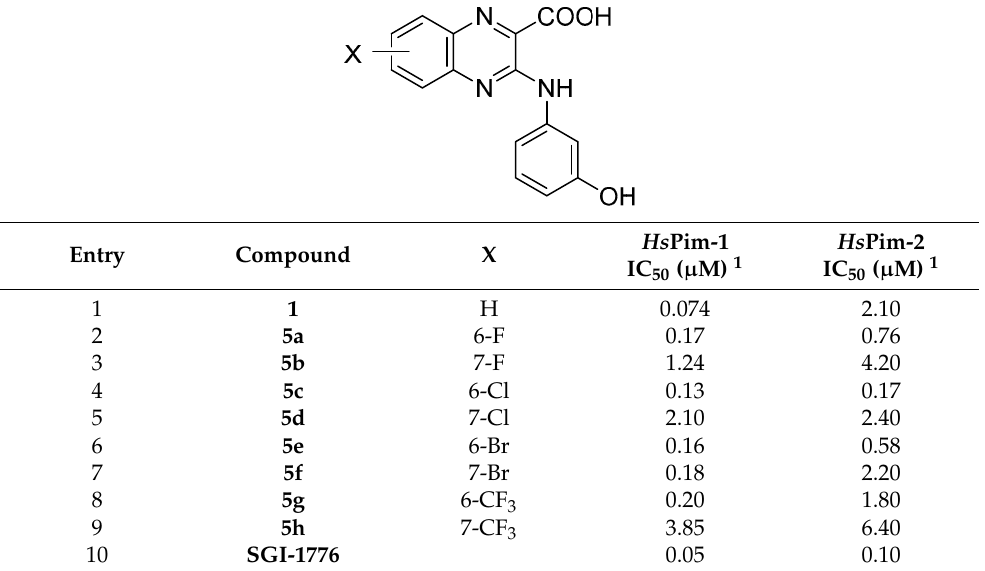
Table 1. Enzymatic assays on Hs Pim-1 and Hs Pim-2 (ADP-Glo method at 10 µ M ATP).